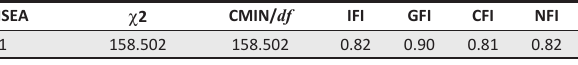
TABLE 2: Indices of the proposed model of the effects of six different conflicts on health outcomes. RMSEA c 2 CMIN/ df IFI GFI CFI NFI 0.71 158.502 158.502 0.82 0.90 0.81 0.82 RMSEA, root mean square error of approximation; CMIN, chi-square value; df , degrees of freedom; IFI, incremental fit index; GFI, goodness-of-fit index; CFI, comparative fit index; NFI, normed fit index.